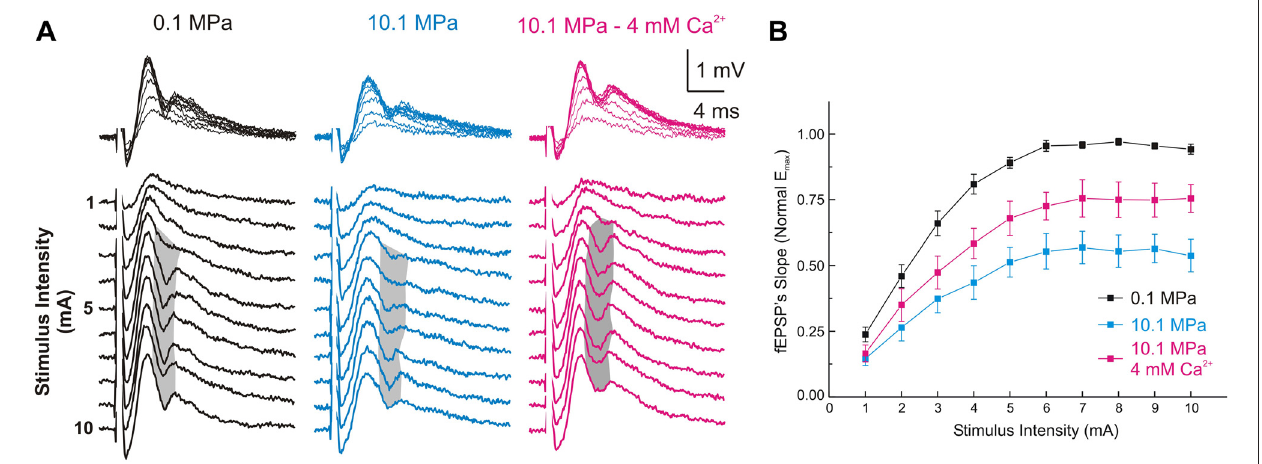
FIGURE 2 | High [Ca 2 + ] o antagonizes high-pressure-induced depression of MPP fEPSPs onto DG’s GCs. (A) Somatic field recordings at the GC layer of the DG showing fEPSP and PS responses to increasing electric stimulation to the perforant path. (B) The MPP fEPSPs’ slopes elicited by all the stimulus intensities are suppressed at 10.1 MPa. Increasing extracellular Ca 2 + ([Ca 2 + ] o ) from 2 to 4 mM in the Ringer’s solution antagonizes the effect of pressure rising the fEPSPs’ slope at all stimulus intensities (means ± SEM, n =